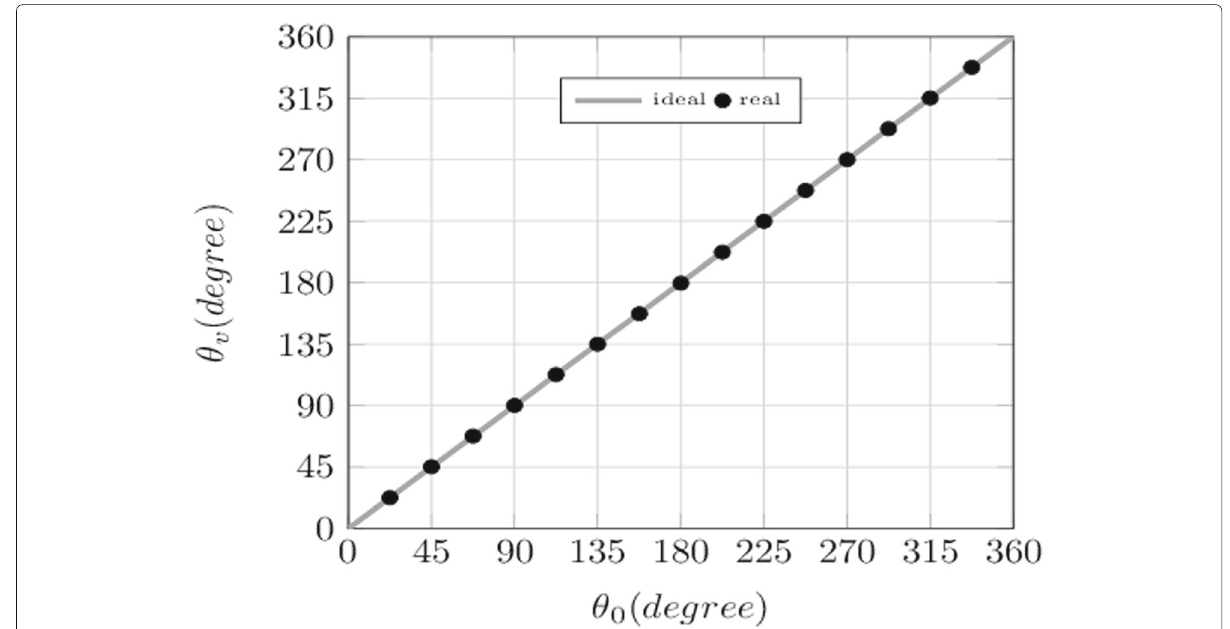
Fig. 13 Convergence of our carrier recovery sub system. The initial oscillation could vary in the full range [0° , 360°], SNR = 2